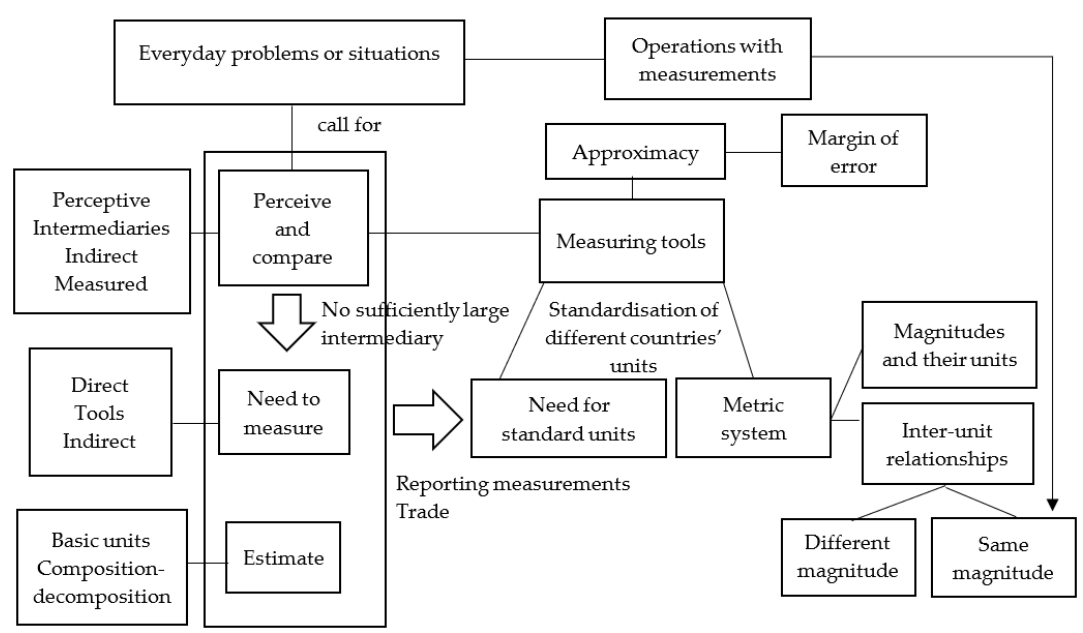
Figure 1. Measurement in primary education: flow chart.